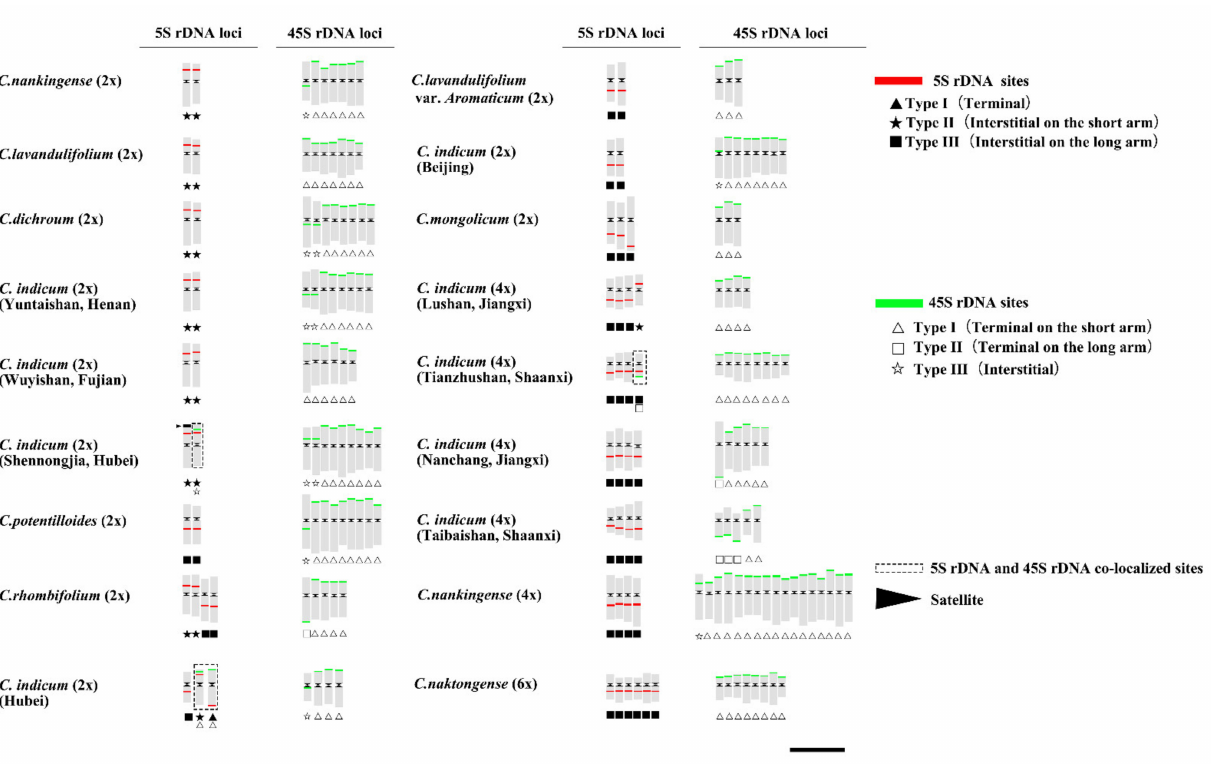
Figure 5. Idiograms of the rDNA sites of Chrysanthemum mitotic metaphase chromosomes. The 5S rDNA sites (red), 45S rDNA sites (green), and colocalized sites are marked by boxes with white dotted